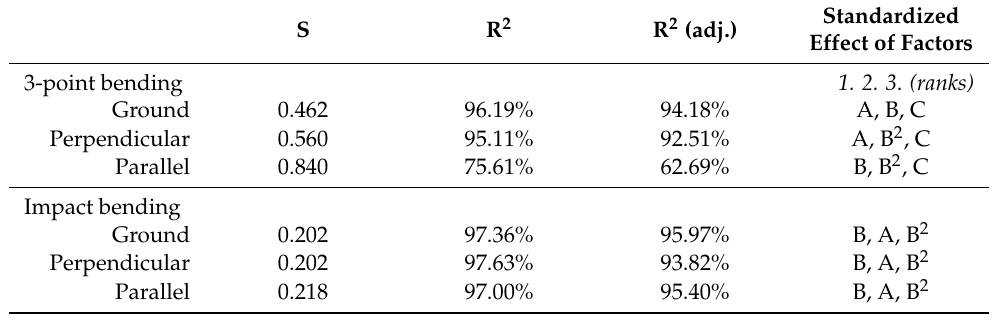
Table 11. Regression analysis—model summaries and the ranks of the significant factors. S R 2 R 2